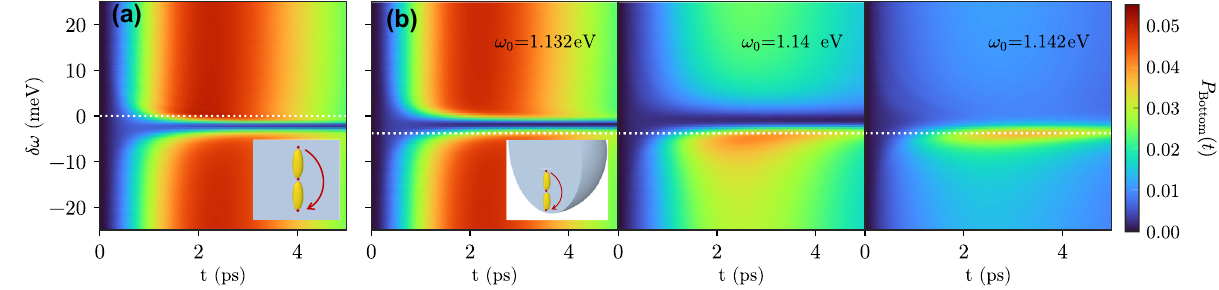
and Gap is detuned from that frequency. The initial 0